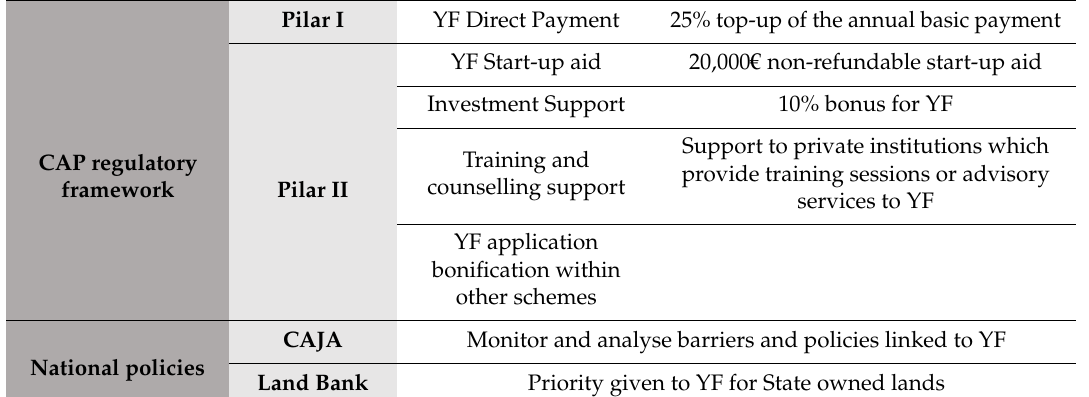
Table 1. Key European Union (EU) and national policies for young farmers (YF) in Portugal and their main characteristics. Legend: CAP, Common Agricultural Policy; CAJA, YF Monitoring